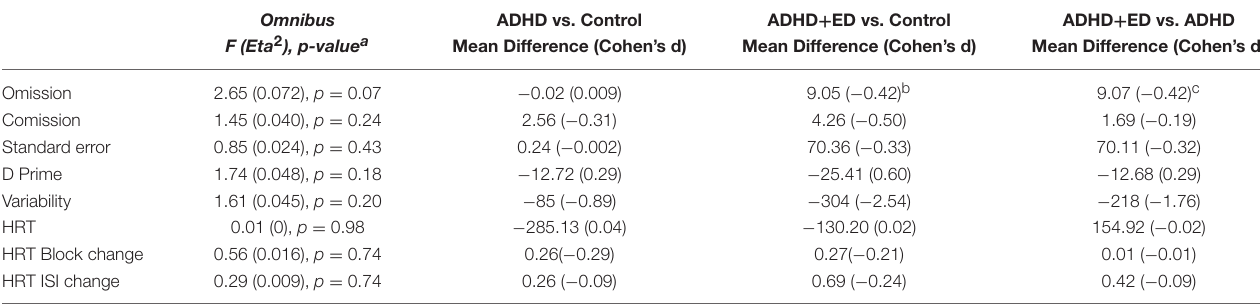
TABLE 5 | Interactions among groups for Conner’s continuous performance test.